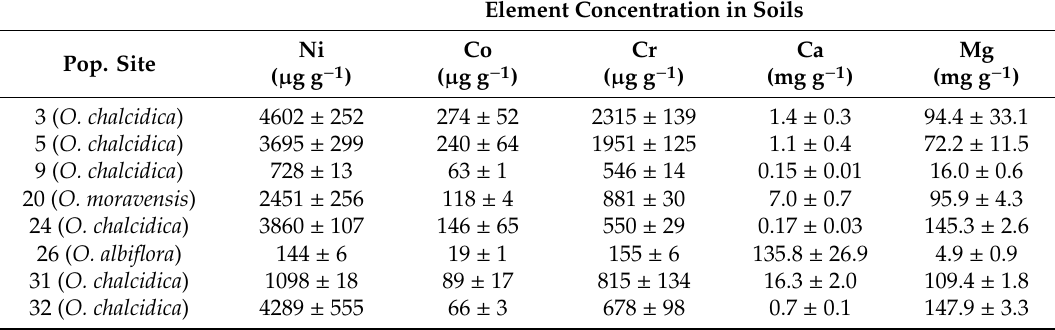
Table 4. Concentration of Ni ( µ g g − 1 d.w.), Co ( µ g g − 1 d.w.), Cr ( µ g g − 1 d.w.), Ca (mg g − 1 d.w.), and Mg (mg g − 1